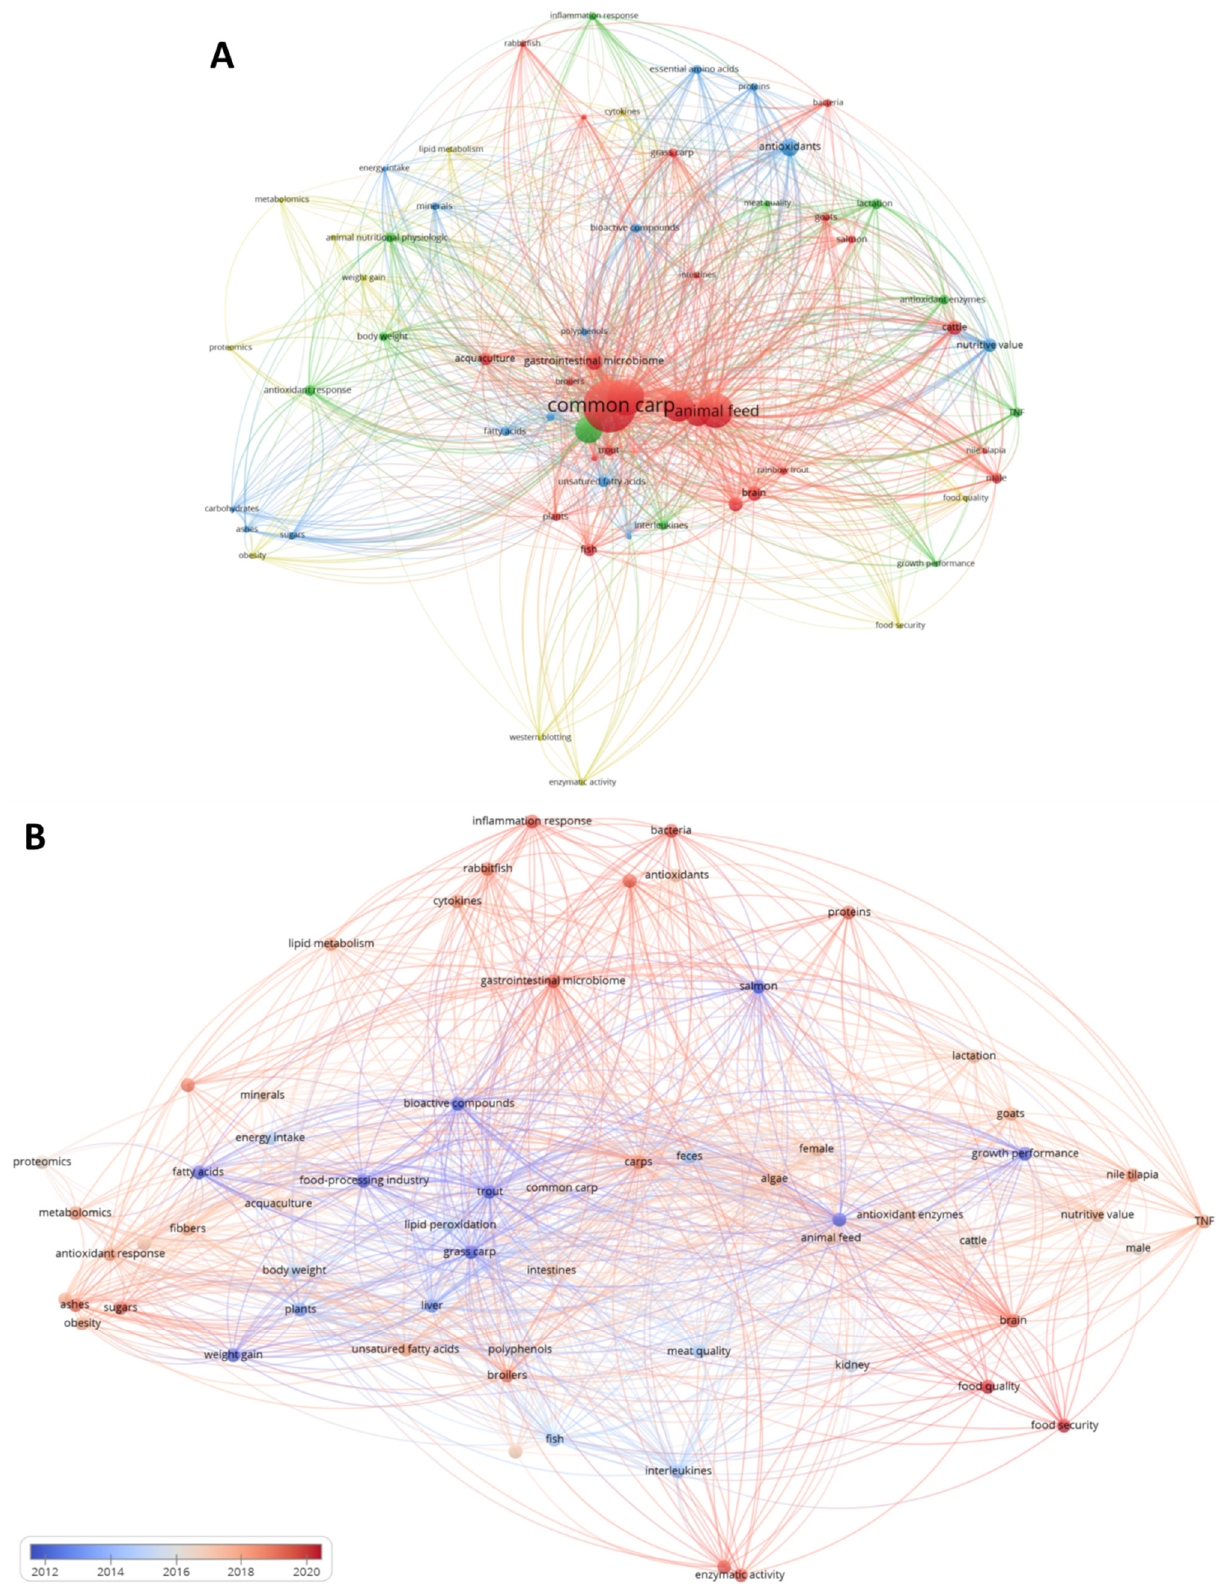
Figure 1. Map of the co-occurrence network of the 75 selected keywords. The prominence of the circles and texts in each cluster represents the strength of their co-occurrence, while the distance of the elements and lines shows the relation and linkage among the different keywords, respectively.